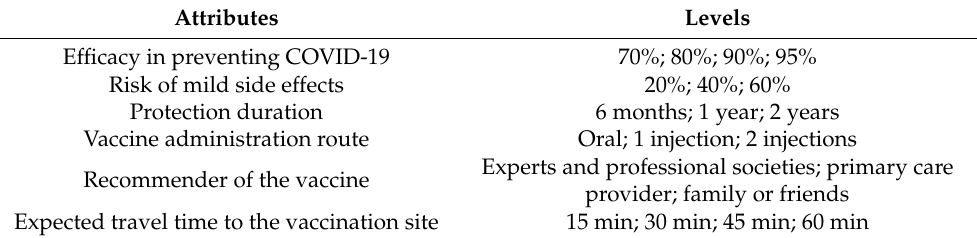
Table 1. Attributes and levels for hypothetical COVID-19 vaccines and vaccination